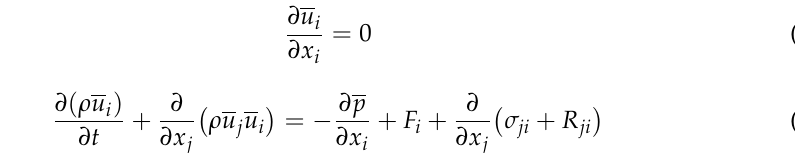
Figure 5. Mounted fin with different rotational directions at a maximum of 20°. ( a ) Front view. ( b ) Side view.